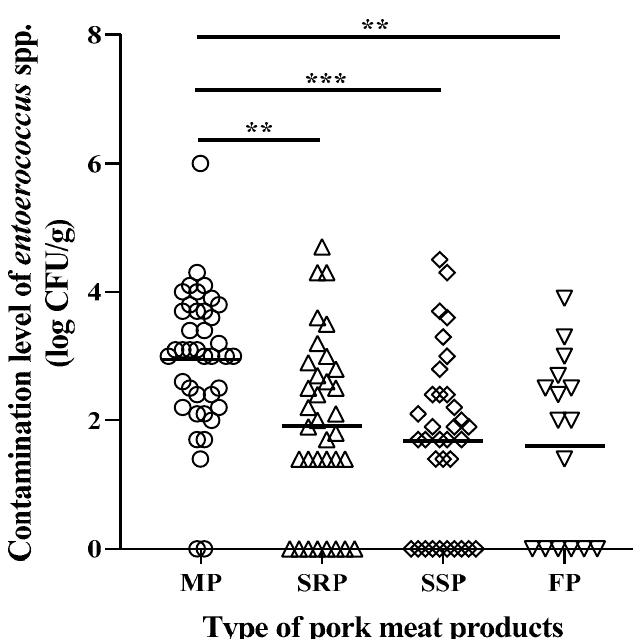
Figure 1. Contamination level of Enterococcus spp. in commercial processed pork meat products.